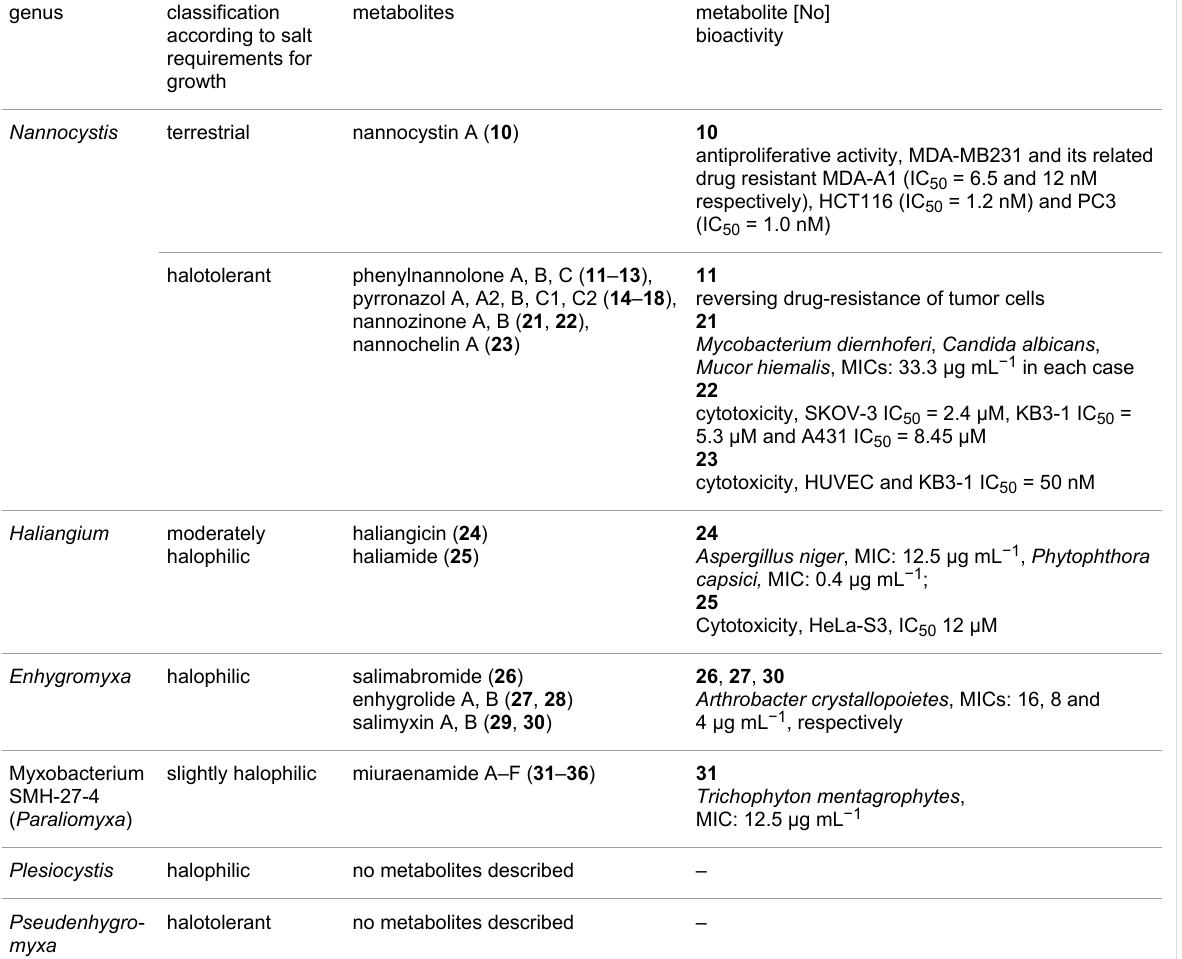
Table 2: Metabolites reported to date from myxobacteria grouped into the suborder Nannocystineae and their bioactivities.